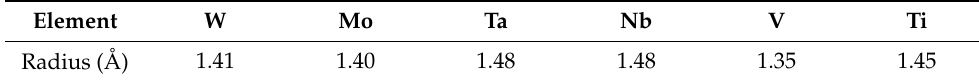
Figure 1. BSE micrographs and XRD patterns ( d ) of as-cast ( a ) WMoTaNb, ( b ) WMoTaNbV and ( c ) WMoTaNbTi alloys. Table 2. The radius of elements of the three alloys.